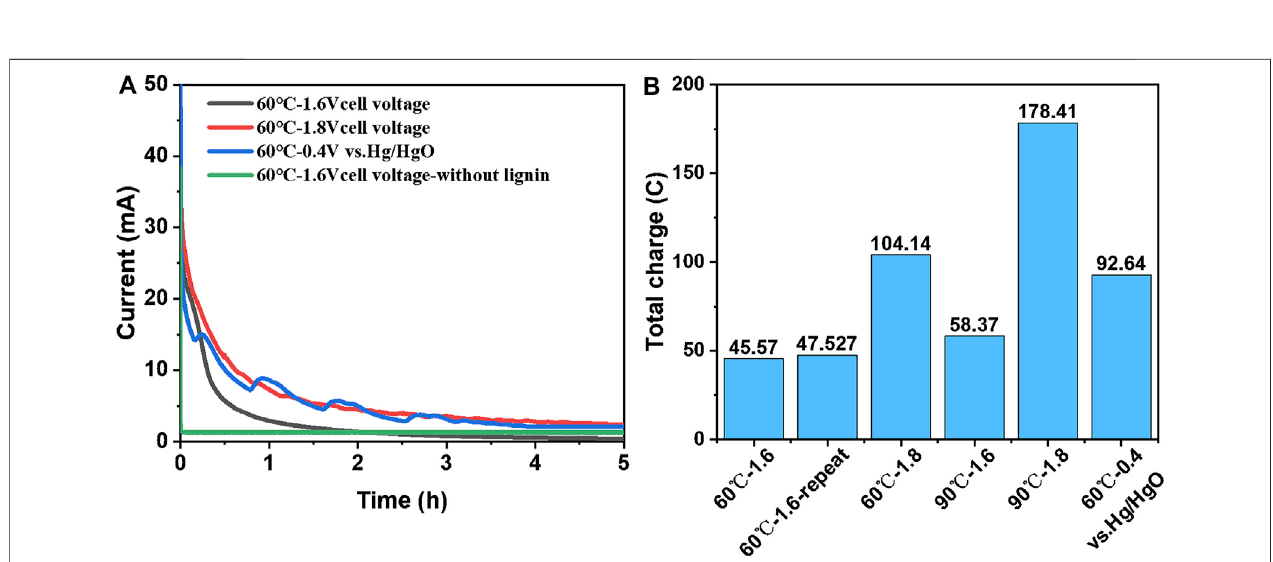
FIGURE 4 | CA tests for LAWE at 60 ° C: (A) I-t curves of LAWE; (B) total transfer charge for CA tests 5 h. Solution: 1 mol/L NaOH and 10 g/L lignin.